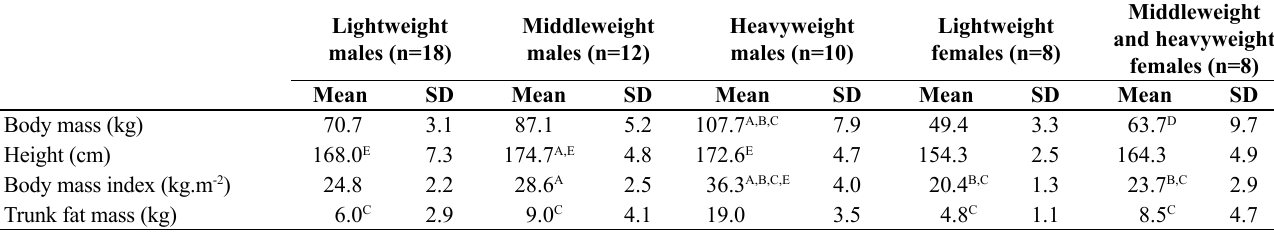
Table 2. Body composition characteristics of male and female powerlifters according to weight classes.